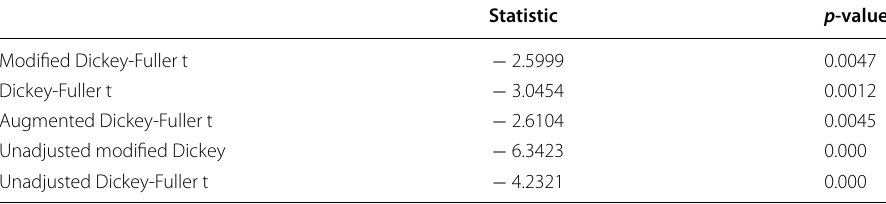
The null hypothesis is ‘no